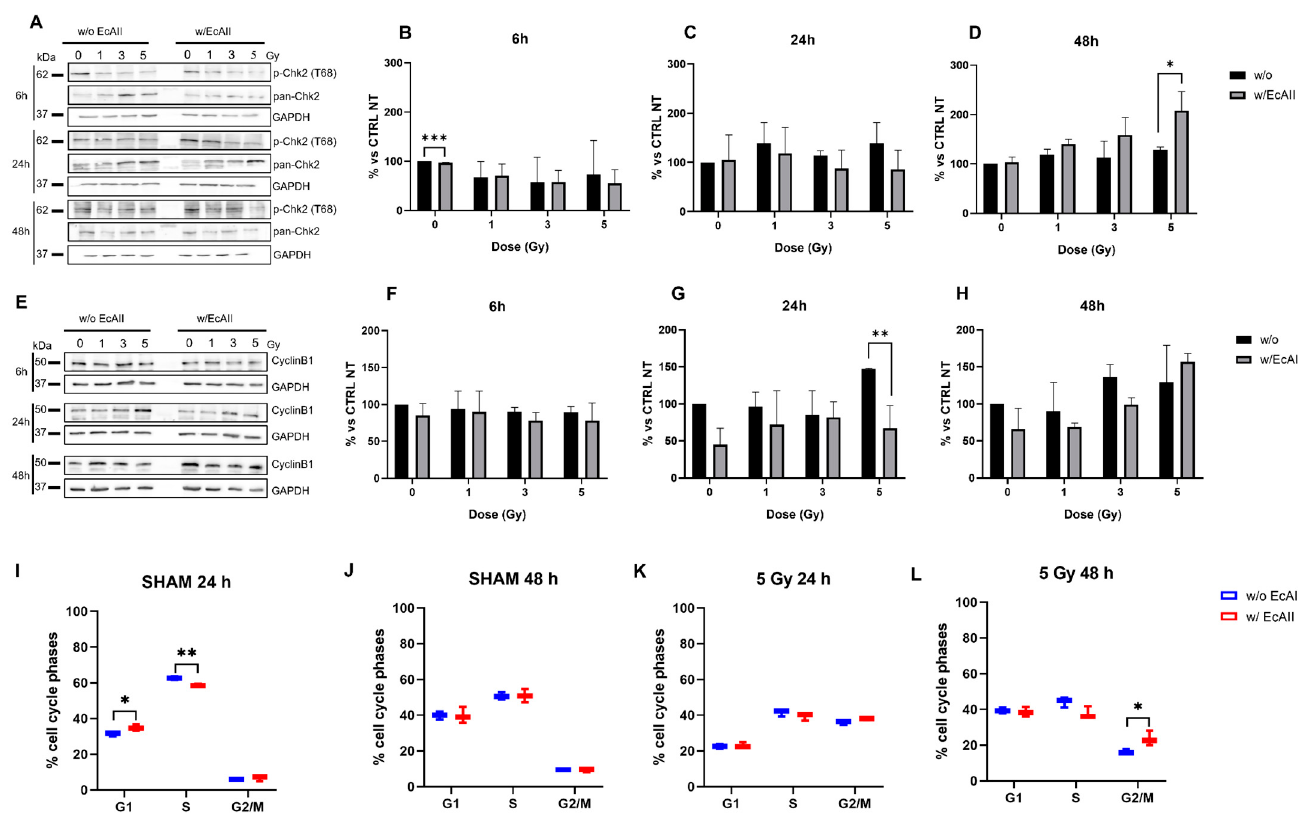
Figure 2. G 2 /M transition phase protein analysis for Caco-2 cells exposed to different doses of X rays (0, 1, 3 and 5 Gy), without (w/o) or with 1 U/mL EcAII (w/EcAII) administered after radiation and cell cycle analysis of CaCo-2 cells exposed to different doses of X rays (0, 5 Gy), without (w/o) or with 1 U/mL EcAII (w/EcAII) administered after radiation. Panel ( A ). Illustrative Western blot images of phosphorylated Chk2 (p-Chk2 (T68)) and pan-Chk2. The densitometric analysis was performed by evaluating the p-Chk2 (T68)/pan-Chk2 ratio, with changes expressed relative to the unirradiated and w/o control at each time point (% vs. CTRL NT). Samples in the absence of EcAII (black bar) and with EcAII (gray bar) were harvested at: Panel ( B ), 6 h after irradiation; Panel ( C ), 24 h after irradiation; Panel ( D ), 48 h after irradiation; Panel ( E ), illustrative Western blot analysis images of Cyclin B1. The densitometric analysis was performed by evaluating the CycB1/GAPDH (loading control) ratio, with changes expressed relative to the unirradiated and w/o control at each time point (% vs. CTRL NT). Samples in the absence of EcAII (black bar) and with EcAII (gray bar) were harvested at: ( F ), 6 h after irradiation; ( G ), 24 h after irradiation; ( H ), 48 h after irradiation. Panel ( I ), percentage of cell cycle phases at 0 Gy w/o or with EcAII at 24 h. Panel ( J ), percentage of cell cycle phases at 0 Gy w/o or with EcAII at 48 h. Panel ( K ), percentage of cell cycle phases at 5 Gy w/o or with EcAII at 24 h. Panel ( L) , percentage of cell cycle phases at 5 Gy w/o or with EcAII at 48 h. Data reported are mean ± SD, obtained from at least three independent experiments. Statistical significance (Student’s t -test) was calculated comparing the w/o and w/EcAII conditions for each dose and time point, and reported as follows: * p < 0.05, ** p < 0.01, *** p < 0.001.